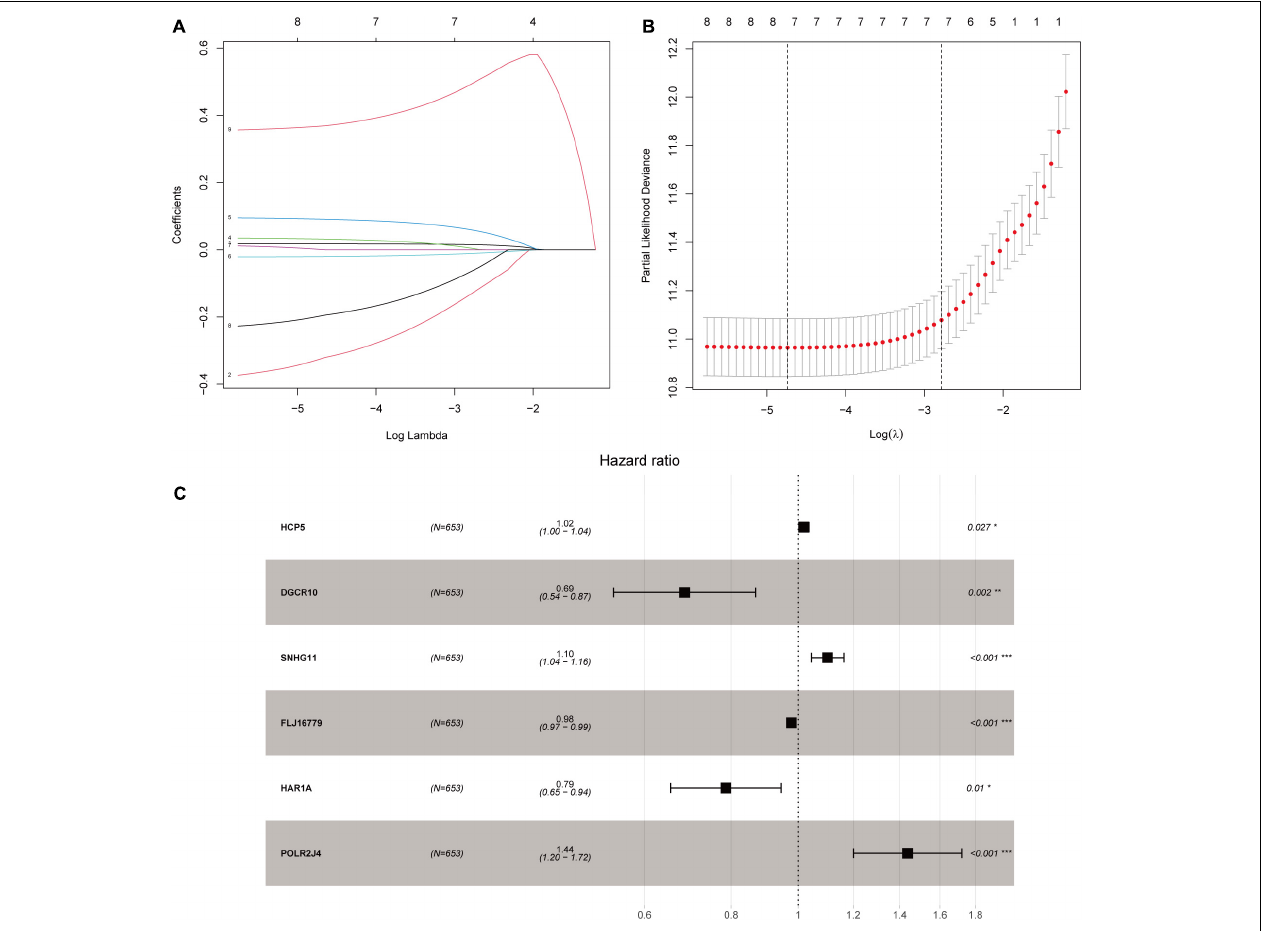
FIGURE 3 | Construction of an immune-related lncRNA prognostic risk score model. (A) LASSO Cox regression analysis of the nine prognostic lncRNAs. (B) Ten-round cross-validation was conducted for the optimal penalty parameter lambda. (C) Multivariate Cox regression analysis of immune-related lncRNAs. * p < 0.05, ** p < 0.01, and *** p < 0.001.